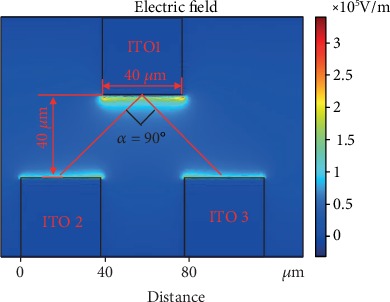
Diagram of the electric field between ITO electrodes when α = 90°.